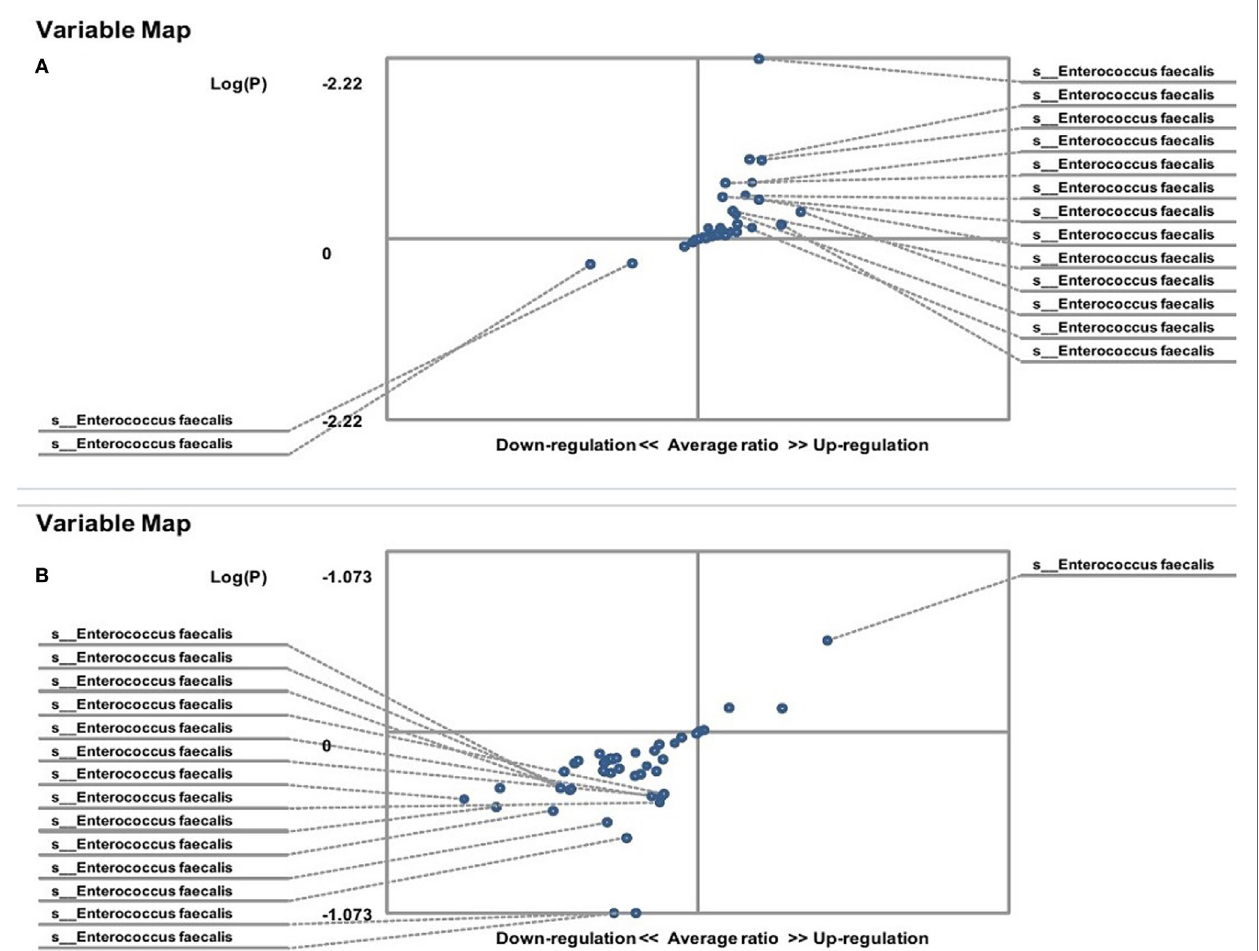
FigUre 3 | Distribution of gut Enterococcus faecalis in Candida albicans- carrier familial Mediterranean fever (FMF) patients. Contribution of variables to differentiation between two groups [ X axis, average ratio between two groups; Y axis, − Log (P)]. The upper-right and left-down corner are the most significant. (a) FMF men with gut C. albicans numbers above baseline level/FMF men with C. albicans below baseline level; (b) FMF women with gut C. albicans numbers above baseline level/FMF women with C. albicans below baseline